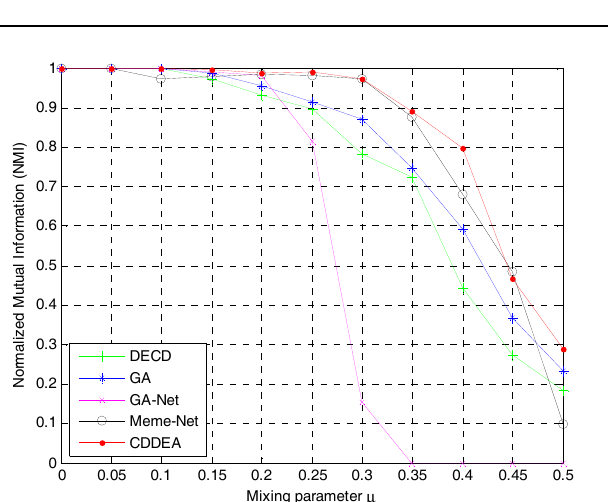
Figure 9. (Color online) Test of the accuracy of CDDEA on the synthetic benchmark network and a comparison with other evolution-based methods.